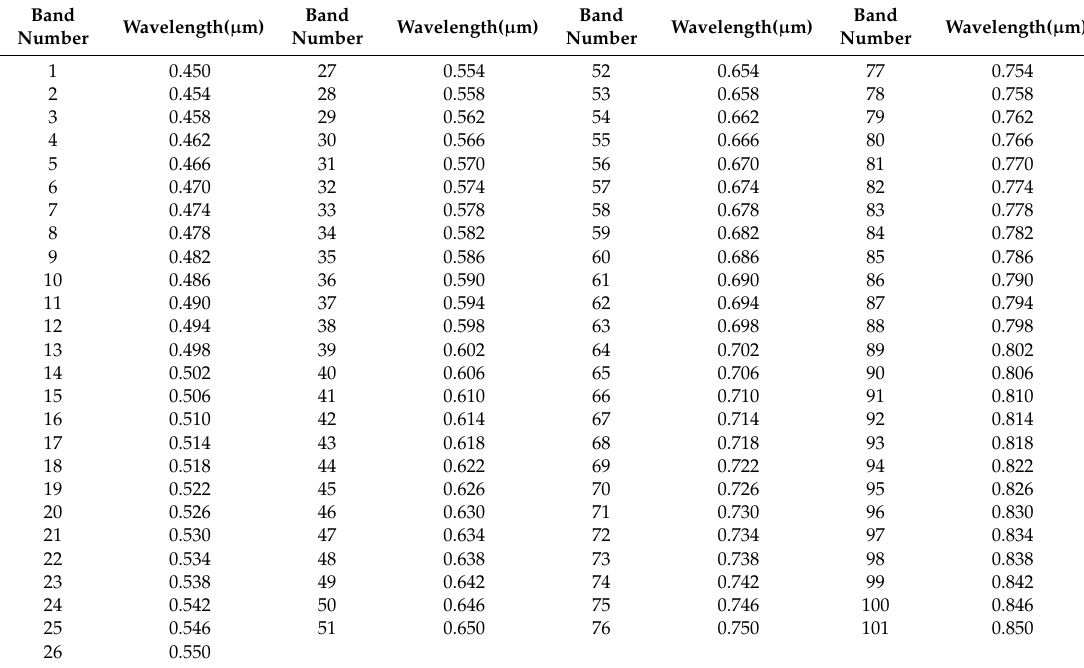
Table A1. The corresponding wavelengths of 101